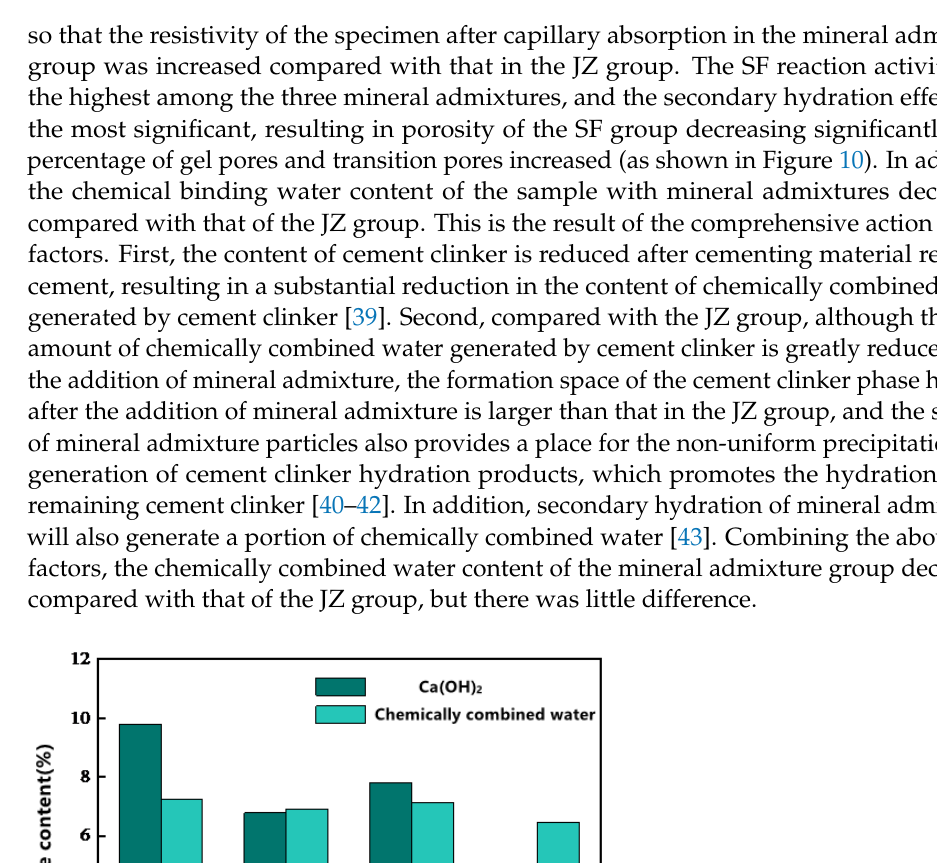
Figure 11. TG curve of cement mortar slurry.